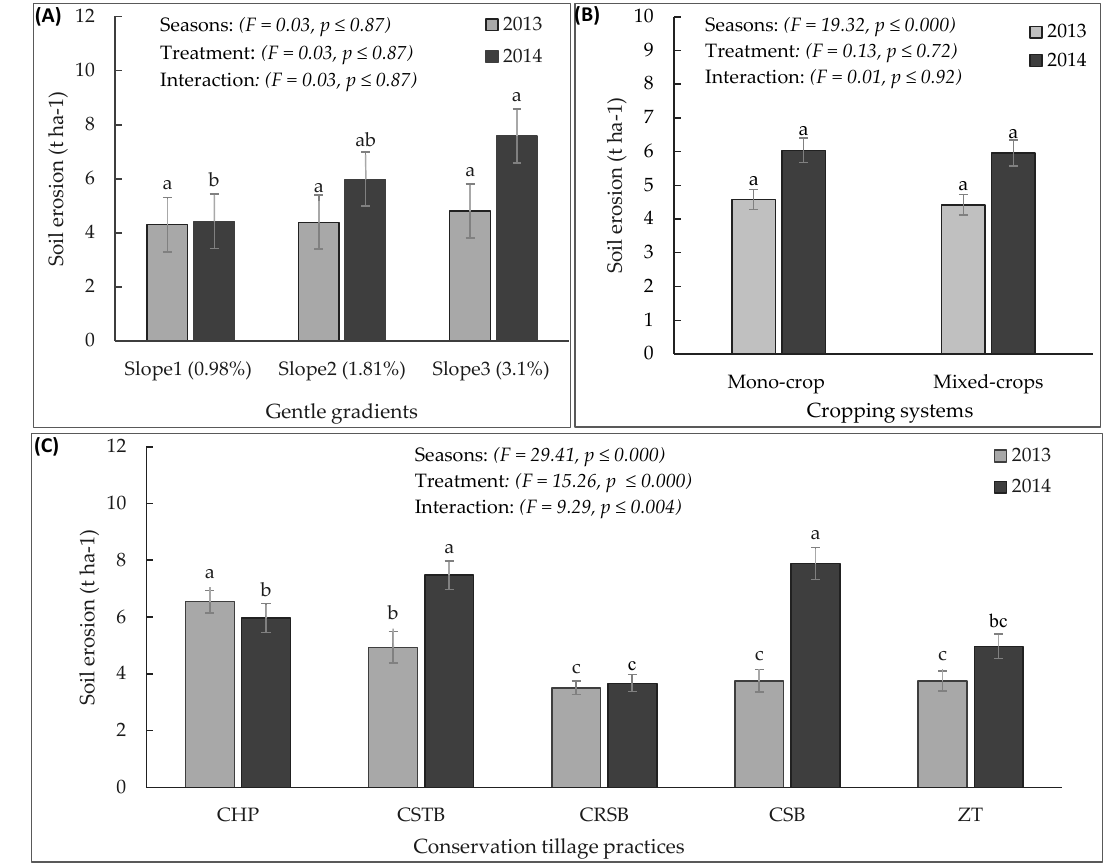
Figure 5. Effect of the slope ( A ), cropping systems ( B ), and conservation tillage practices ( C ), on eroded soil (t ha-1) for both seasons 2013 and 2014. Means followed by the different latter in same latter do not differ significantly at (LSD ; p ≤ 0.05).